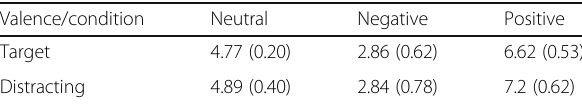
sets (standard deviation in